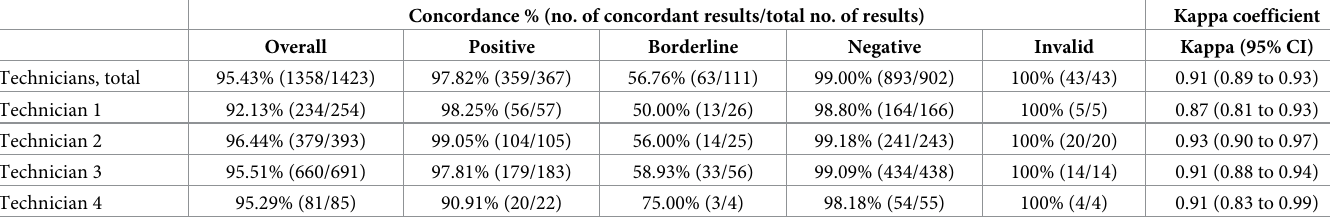
Table 2. Concordance and kappa coefficients of the qualitative test results read by the technicians and ELISPOT plate imager. Concordance % (no. of concordant results/total no. of results)